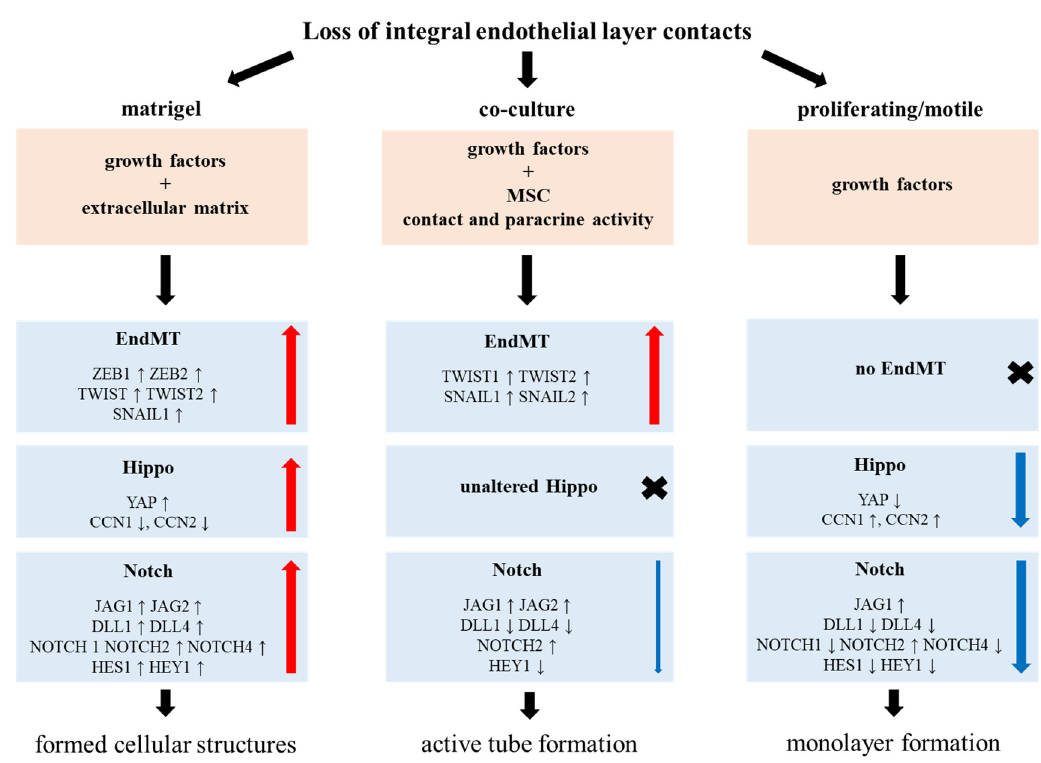
Figure 9. Hypothetical scheme illustrating processes occurring in HUVECs grown on Matrigel TM , in co-culture with MSCs, and proliferating/motile HUVECs. Red arrows indicate expression level increase, blue arrows indicate expression level decrease. Arrows thickness indicates the intensity of the expression change.